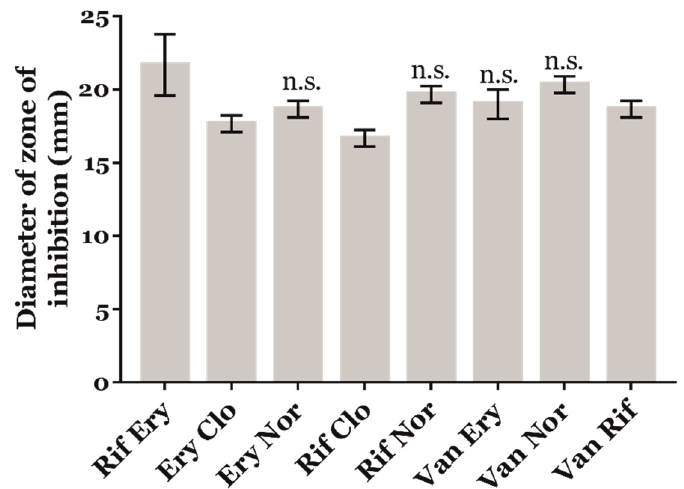
Figure 3. Antimicrobial susceptibility of R. equi 103S + to 5 µg of different combinations of antimicrobial compounds, including clofazimine (Clo), erythromycin (Ery), norfloxacin (Nor), rifampicin (Rif), and vancomycin (Van). The diameter of the growth inhibition zones was measured to the nearest millimetre, and the mean ± SD of three independent experiments was plotted. Two-way ANOVA and post-hoc Tukey´s multiple comparison tests were performed to assess for statistical significance across conditions. N.s.: Not significant.